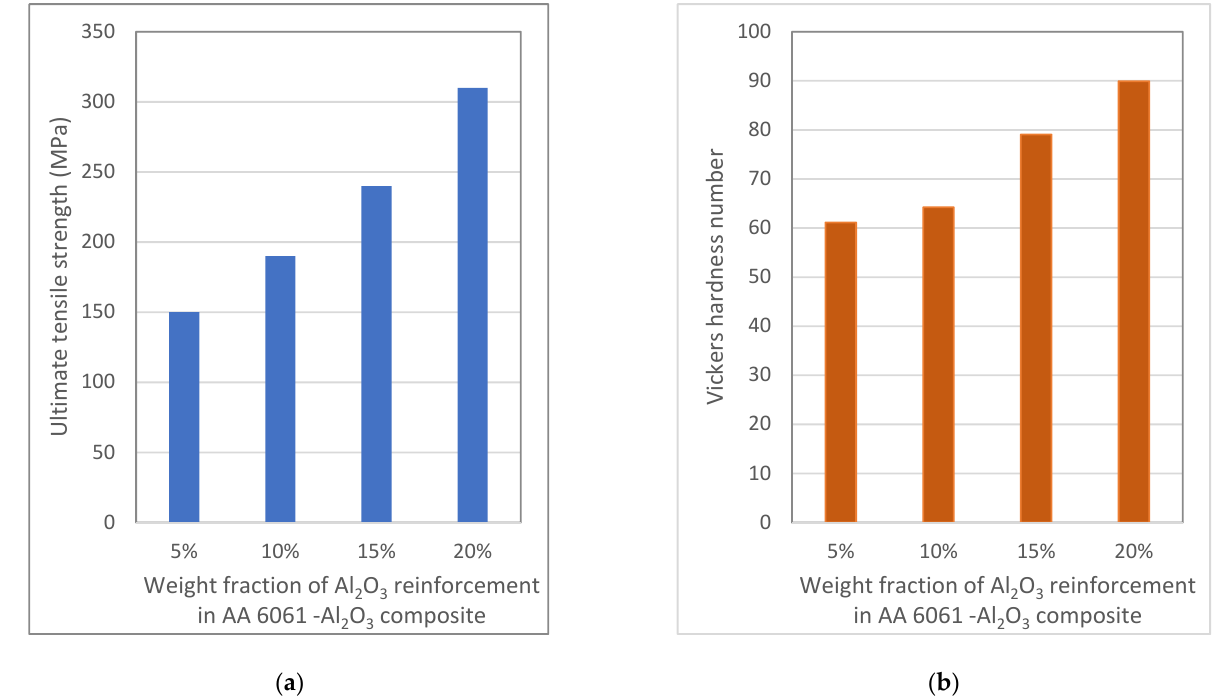
Figure 4. ( a ) Variation of ultimate tensile strength (UTS) of AA 6061-Al 2 O 3 composite with increased content of Al 2 O 3 ; ( b ) Variation of Vickers hardness value of AA 6061-Al 2 O 3 composite with increased content of Al 2 O 3 (Data from [45]).